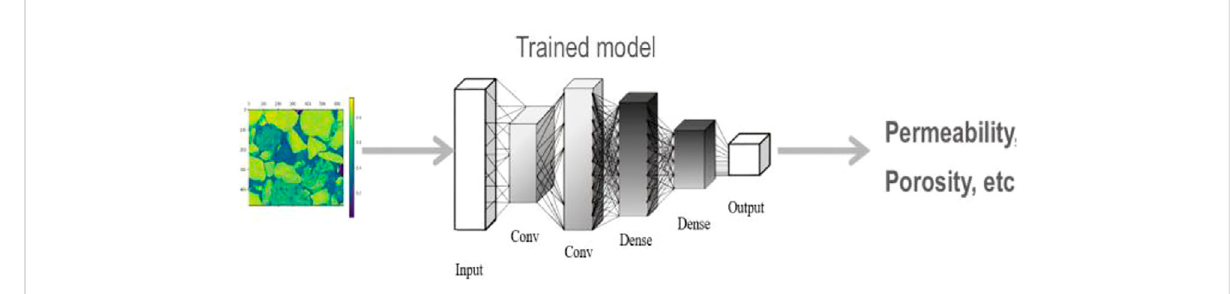
FIGURE 12 A trained machine learning model takes 2D slices of the geometry as an input and estimate the property of interest without the lengthy and biased image processing (Araya-Polo et al.,